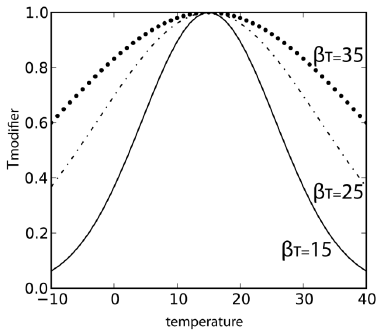
Figure 7. A graph illustrating the behaviour of the modifier function. The modifier function is a bell shaped curve whose response is constrained to the range 0 to 1 ( y -axis). Table 2. Overview of parameter estimates obtained through model